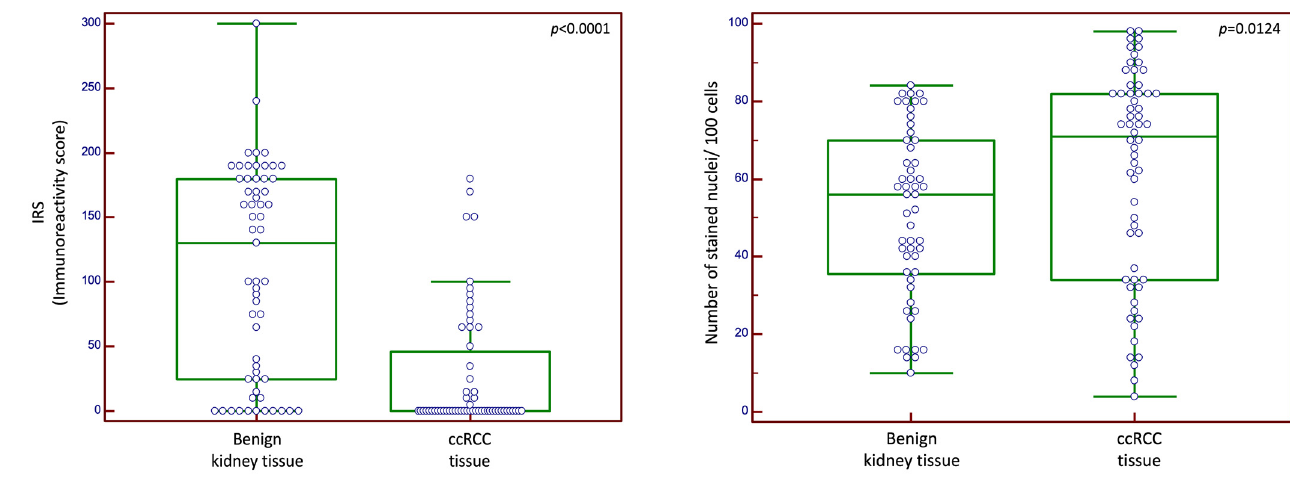
Figure 1. Cytoplasmic and nuclear expression scores for cohort n 1 (primary ccRCC cohort). Abbre- viations: IRS: immunoreactivity score; ccRCC: clear cell renal cell carcinoma. Green box represents median and 1st and 3rd quartile. Purple circles are individual values, circles outside the box are outside values.